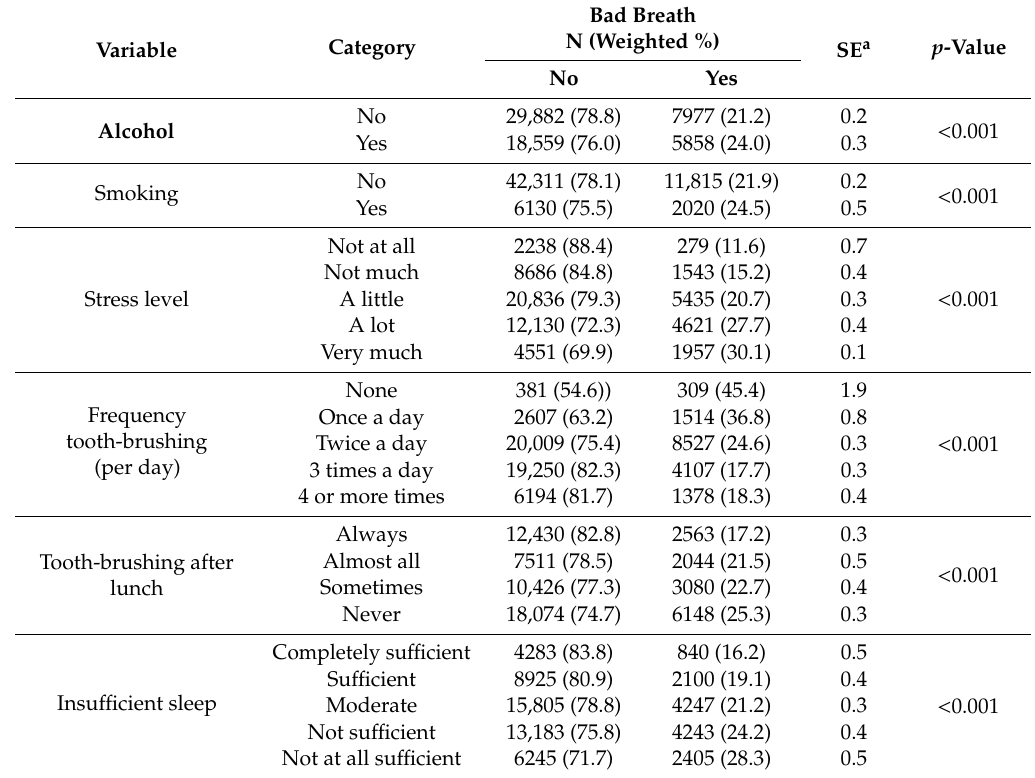
Table 2. Bad breath according to health behaviors (N =